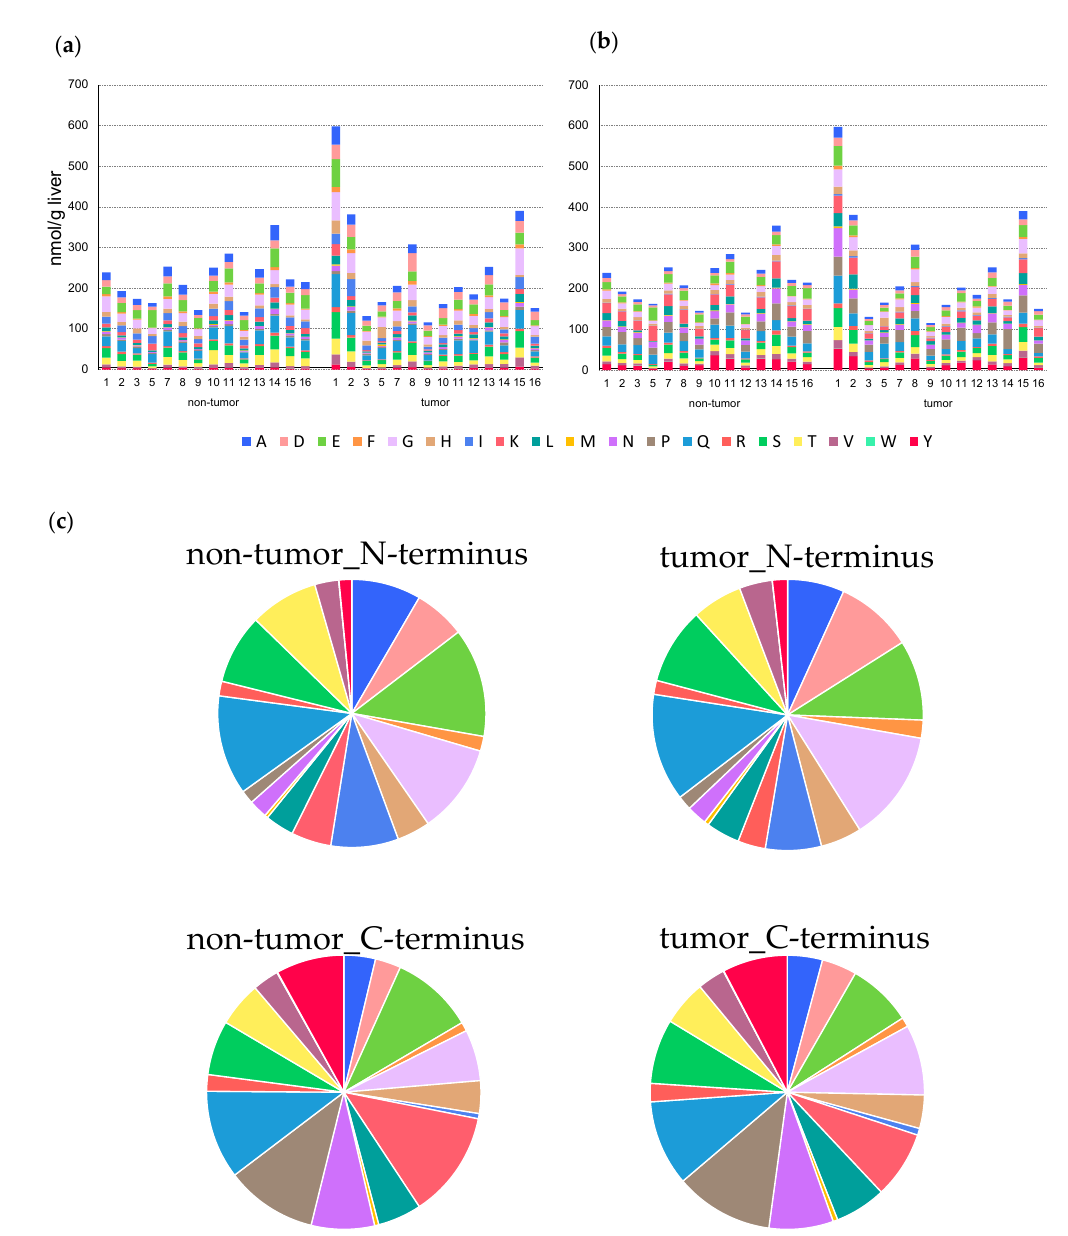
Figure 3. Amino acid composition of N-terminus ( a ) and C-terminus ( b ) in dipeptide detected from each liver tissue. The columns represent the number of moles (nmol/g liver). ( c ) The difference in the average composition ratio of N-terminal and C-terminal amino acids in each tissue.